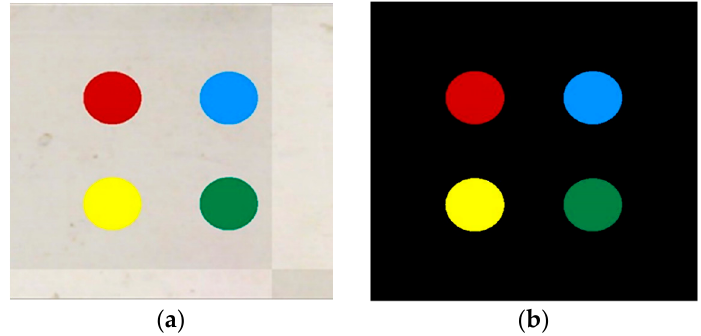
7 of 21 Table 1. YCBCR base color thresholding for blue, green, yellow, and red.